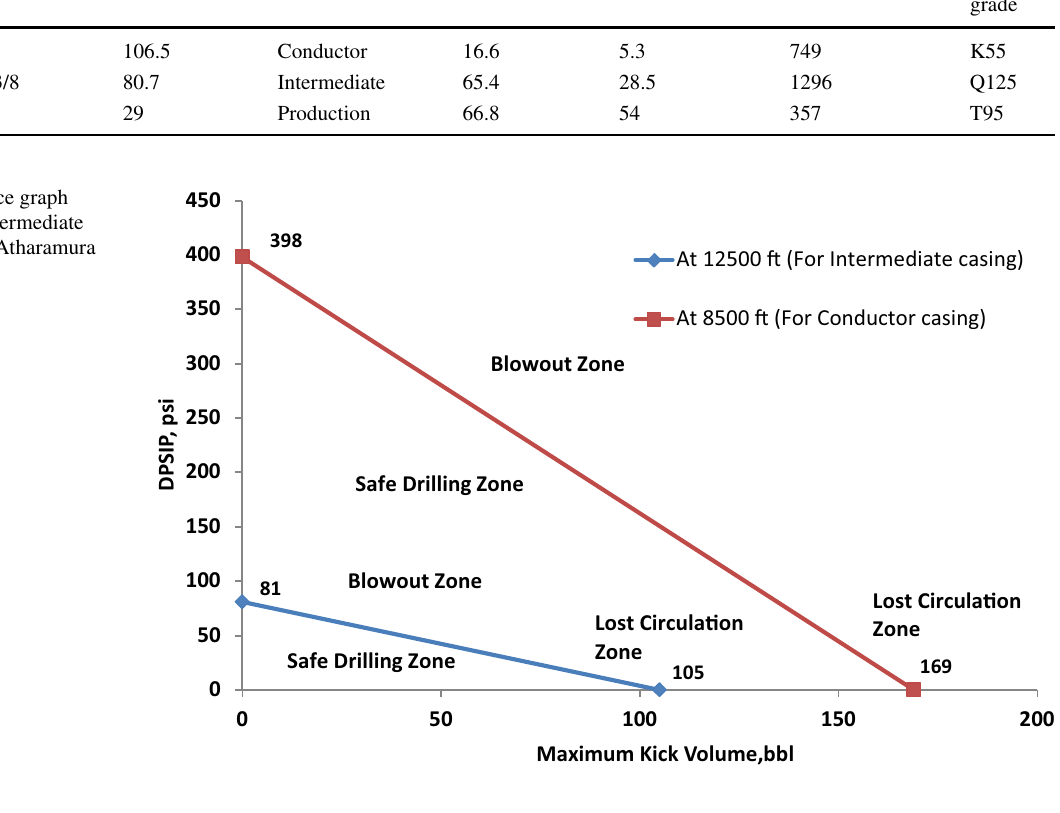
Table 5 Properties of selected casing pipes